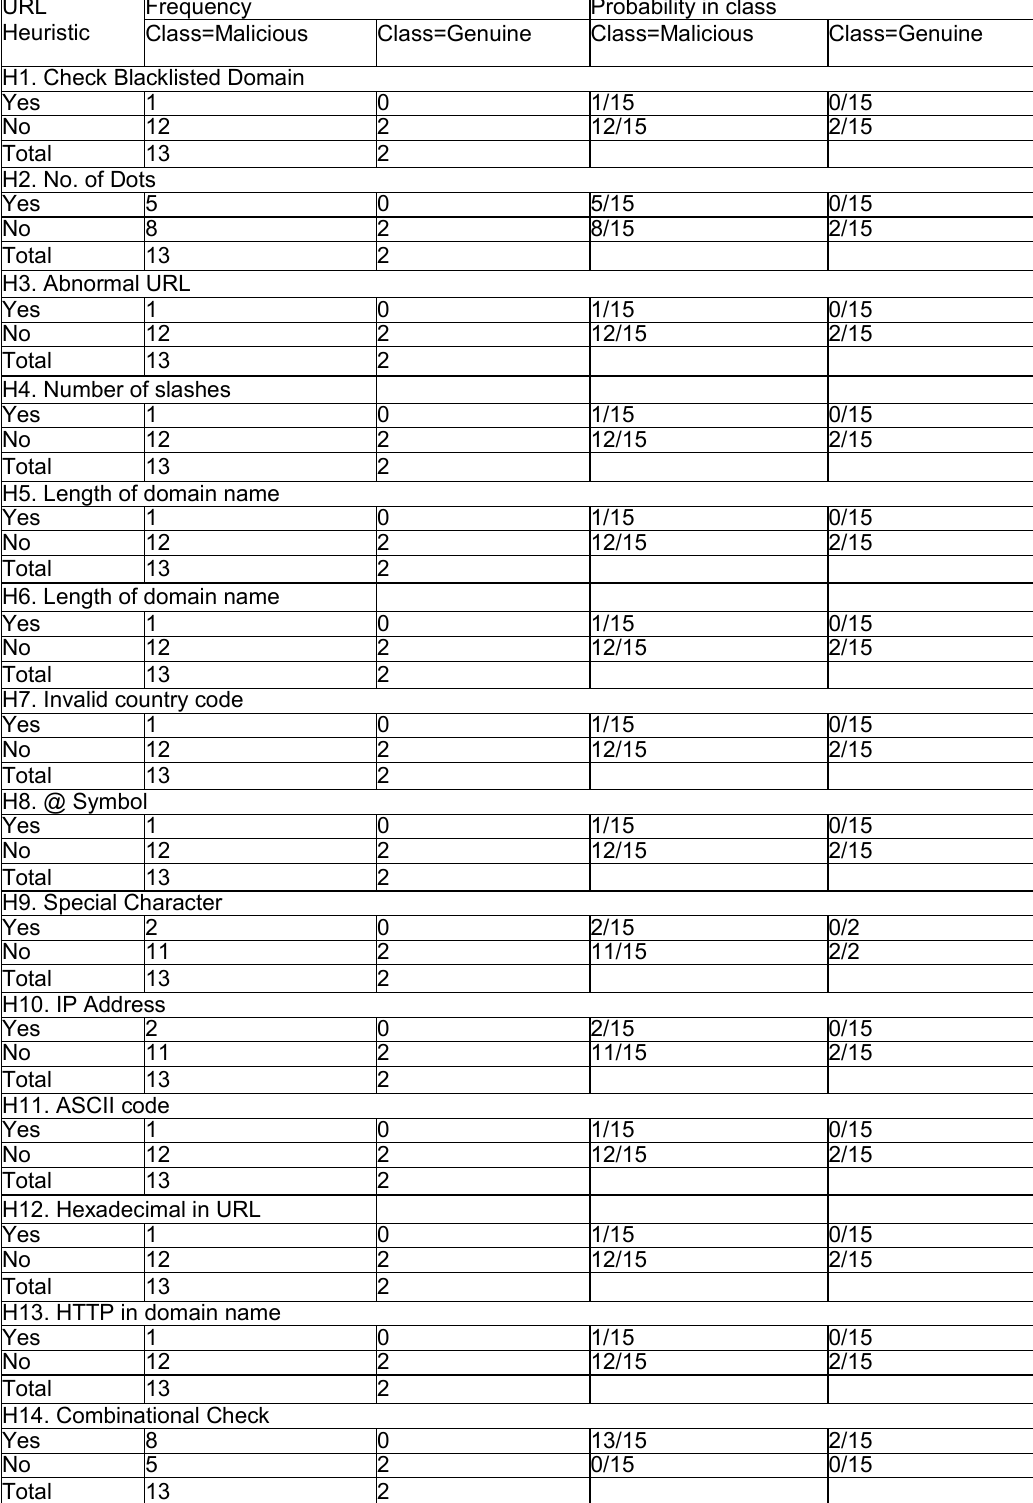
Table 4. Naïve Bayes Classification of